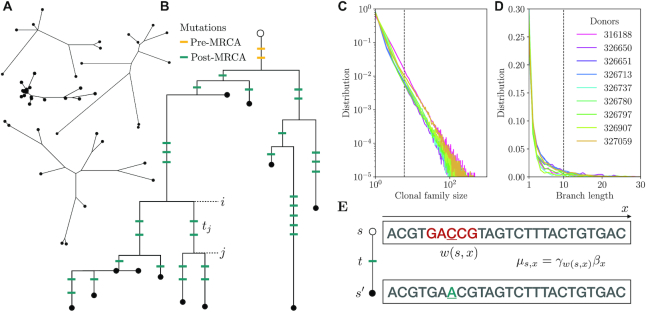
Repertoire-wide framework to model somatic hypermutations (SHM) in out-of-frame lineages. (A) Examples of out-of-frame clonal families. (B) An example of a phylogeny with marked pre- and post-Most Recent Common Ancestor (MRCA) mutations. Only post-MRCA mutations are used for learning the somatic hypermutation model. (C). Clonal family size distribution. Phylogenies were inferred for families with more than 5 unique sequences. (D) Branch length distribution. Mutations encoded in branches shorter than 10 mutations were used for model inference. (E) Context and position dependence of the mutation rate across a sequence. In this example, the underlined C mutates to A, in the GACCG context denoted as \documentclass[12pt]{minimal}
\usepackage{amsmath}
\usepackage{wasysym}
\usepackage{amsfonts}
\usepackage{amssymb}
\usepackage{amsbsy}
\usepackage{upgreek}
\usepackage{mathrsfs}
\setlength{\oddsidemargin}{-69pt}
\begin{document}
}{}$w$\end{document}(s, x). The mutation rate μs, x depends both on the sequence s and the position x, through the context dependent rate γ\documentclass[12pt]{minimal}
\usepackage{amsmath}
\usepackage{wasysym}
\usepackage{amsfonts}
\usepackage{amssymb}
\usepackage{amsbsy}
\usepackage{upgreek}
\usepackage{mathrsfs}
\setlength{\oddsidemargin}{-69pt}
\begin{document}
}{}$w$\end{document}(s, x) and the position dependent rate βx.